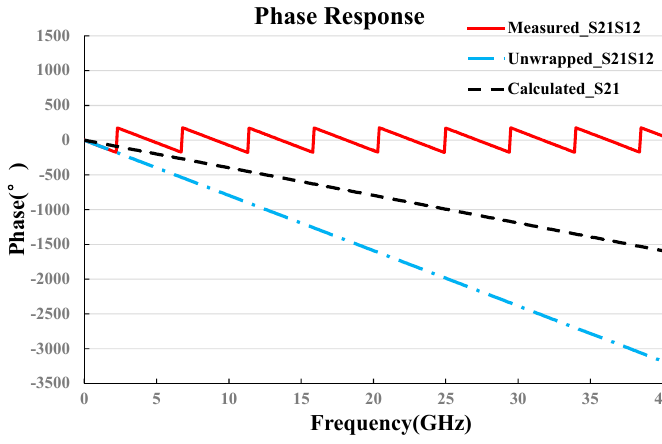
Figure 9. The phase response characteristics.